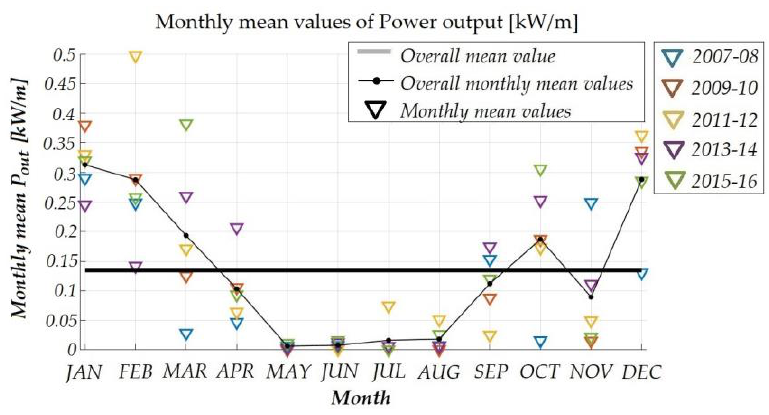
Figure 17. Monthly mean values of power